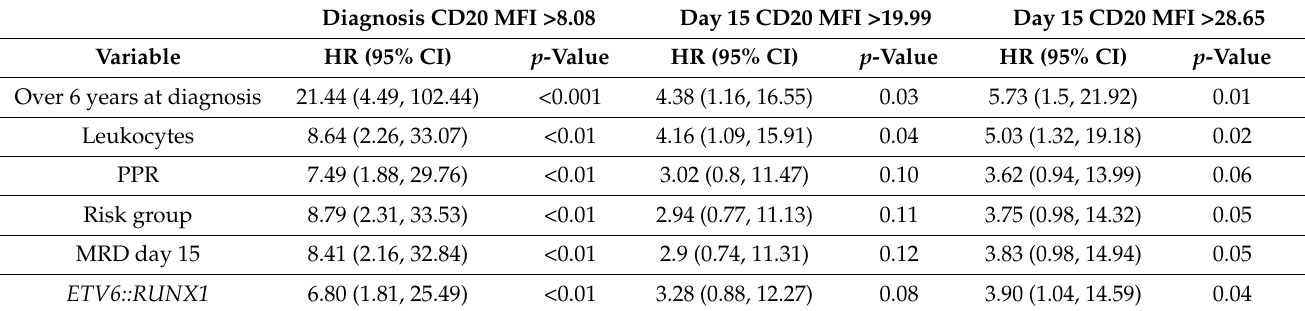
Table 5. Multivariable Cox regression model analysis of